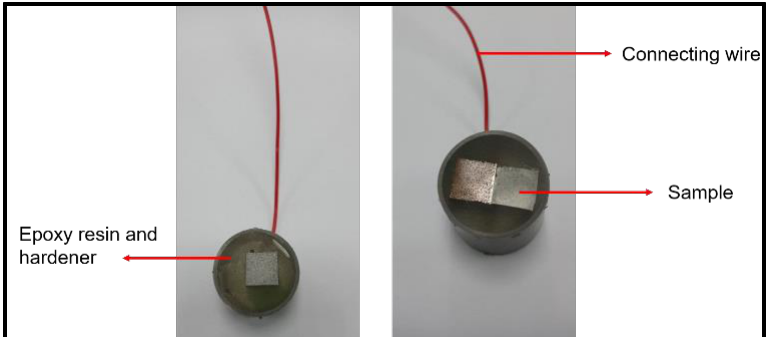
Figure 3. Mounted samples before the polishing process.